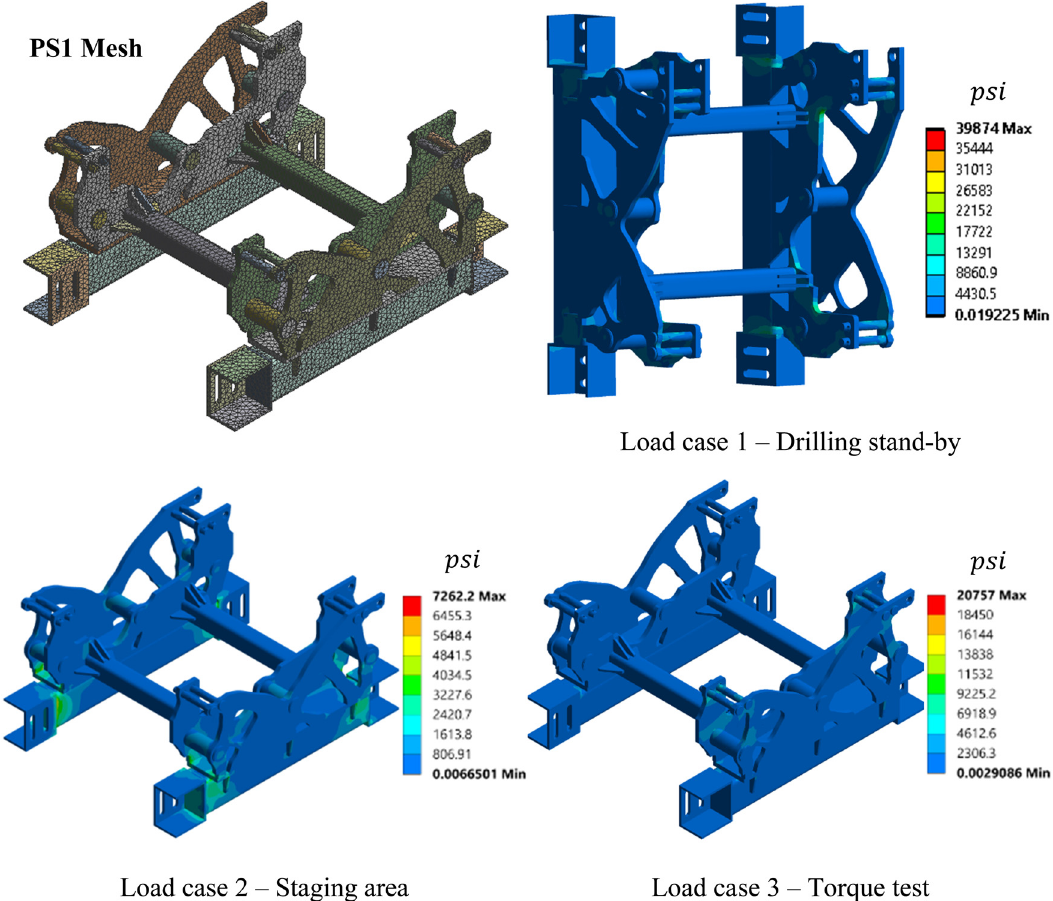
Figure 16: Structural response of topology - optimized result from PS1 against three load